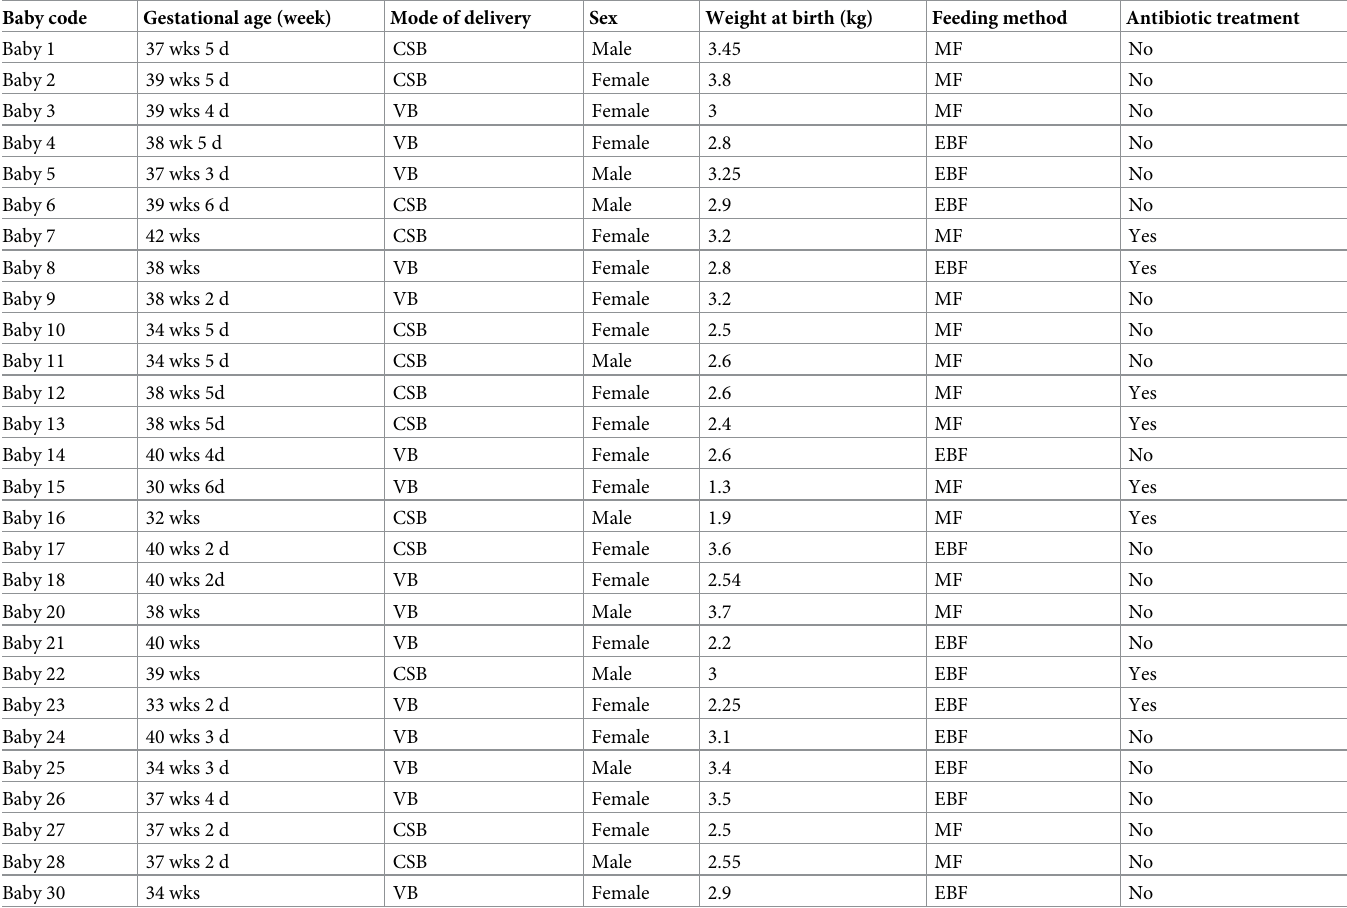
Table 1. Characteristics of study infants at